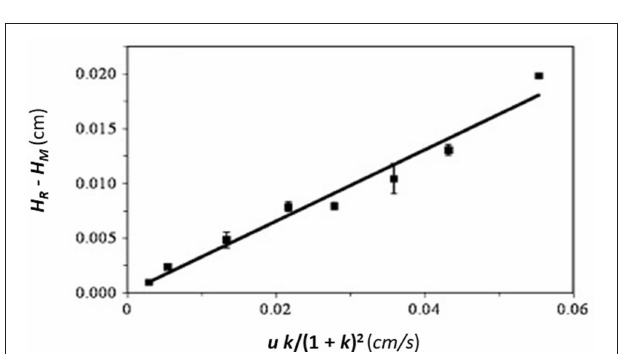
k ) 2 , as obtained by peak profiling for FIGURE 5 | Plot of H R – H M vs. ( uk )/(1 + the injection of 5-(4-hydroxyphenyl)-5-phenylhydantoin ( p -HPPH) onto a column containing immobilized HSA. Reproduced with permission from Tong and Hage (2011). Copyright 2011